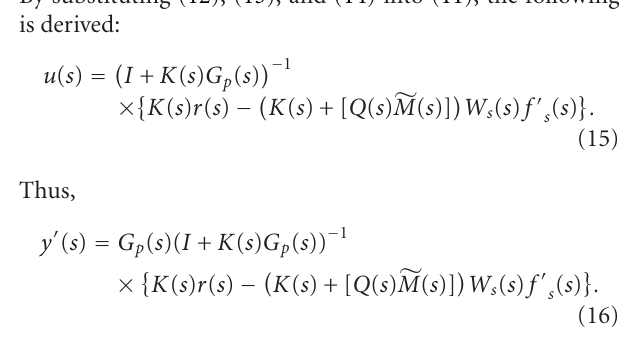
Figure 1: Block diagram representation of H ∞ problem formula- tion for the proposed FTCS design.